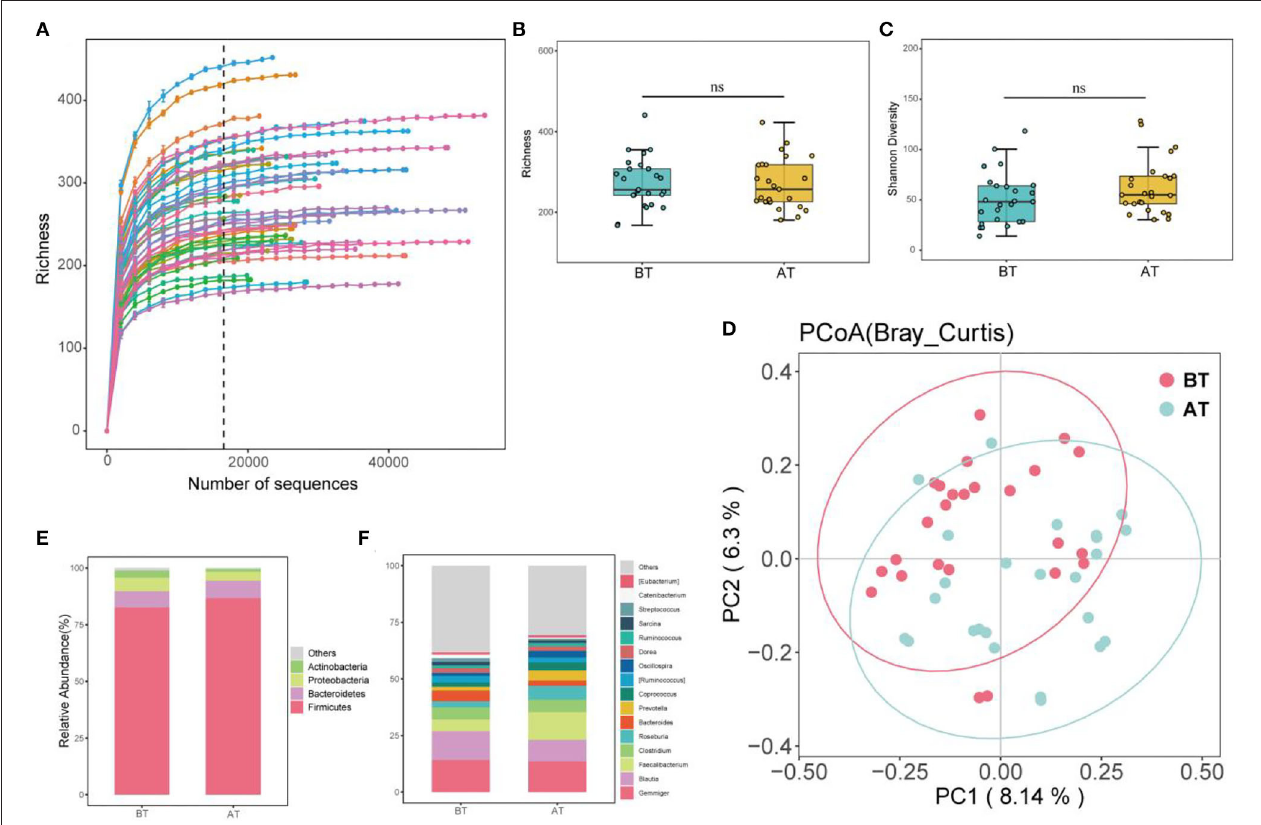
FIGURE 1 | Alpha, Beta diversity, and gut microbial composition. (A) Rarefaction curves for intestinal microbiota observed ASV richness. The color lines indicate BT and AT samples, the dashed black line indicates the selected rarefaction depth used to generate the box plots below each curve, 16,589 seqs/sample for microbial communities. (B) Community richness of intestinal microbiota in BT and AT samples (Richness); (C) Community diversity of intestinal microbiota in BT and AT samples (Shannon diversity), ns, no significant. (D) Principal coordinate analysis (PCoA) of intestinal microbiota of mice under different group. (E) Relative abundance of dominant phylum taxa ( > 1%) in intestine from each group. (F) Relative abundance of dominant genus taxa ( > 1%) in intestine from each group.